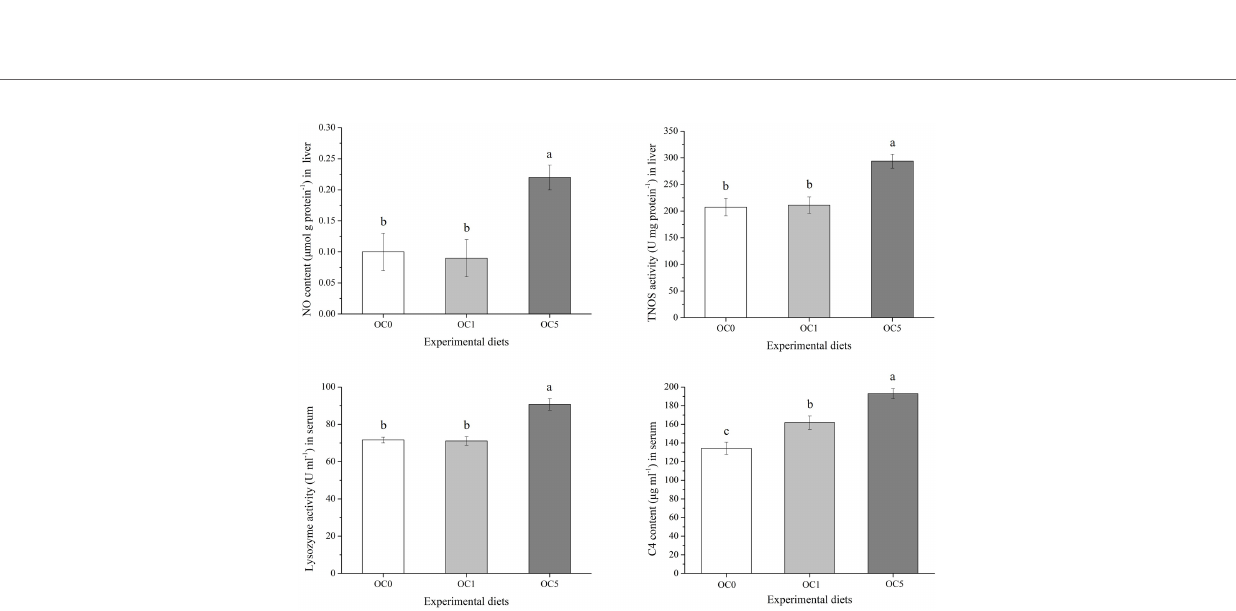
FIGURE 3 | Villus length ( A , m m) and digestive enzymes activities (B) in the mid gut of T. ovatus fed experimental diets, and mid-gut (C) and liver morphology (D) of fi sh fed OS0 (C-1, D-1), OS1 (C-2, D-2), and OS5 (C-3, D-3) diets. LPS, lipase (U g protein -1 ); AMS, amylase (U mg protein -1 ); PEP, pepsin (U mg protein -1 ). The red arrow indicated the in fi ltration of in fl ammatory cells. The black arrow indicated the lipid droplet. Values were presented as mean ± SE (n = 3). The small letters indicated signi fi cant differences at P < 0.05. Scale bar: 100 m m.